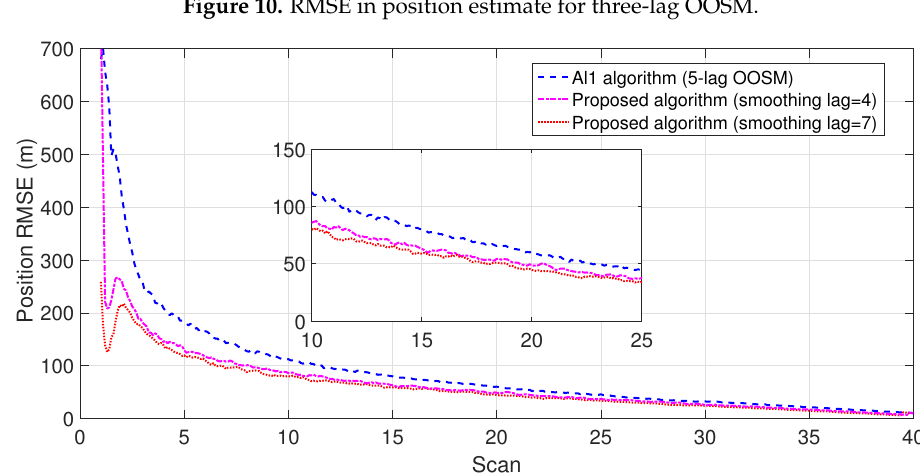
Figure 10. RMSE in position estimate for three-lag OOSM.